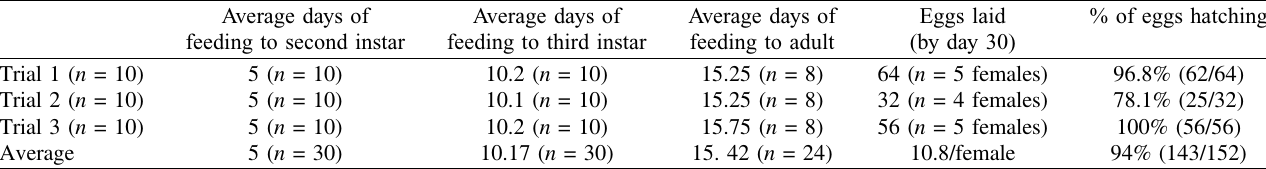
Table 1. Life history traits of lice fed on in vitro system. Average days